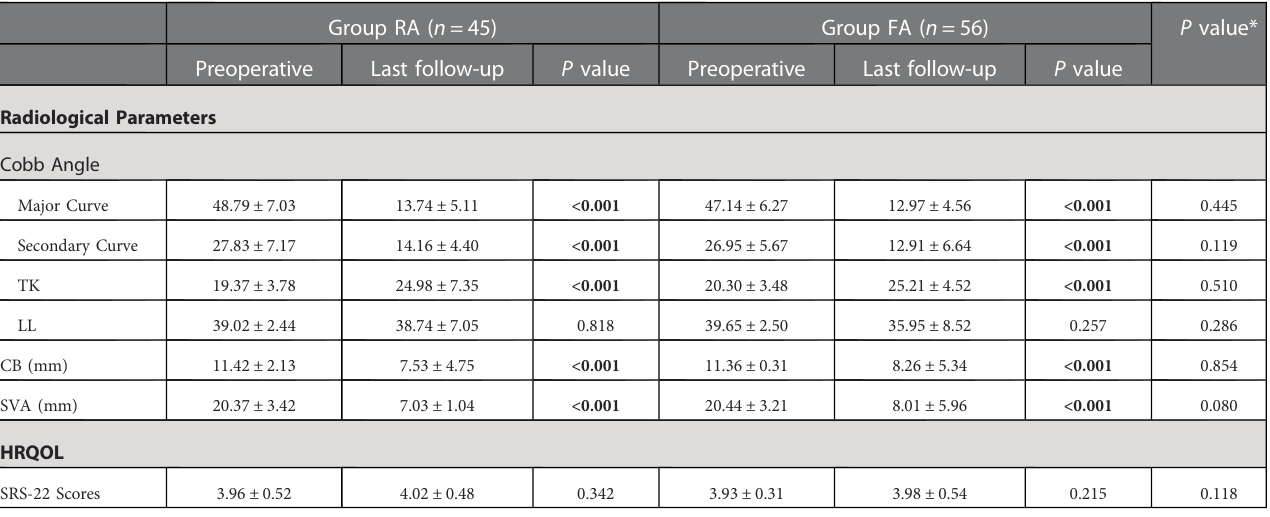
TABLE 3 Preoperative and last follow-up parameters between group RA and group